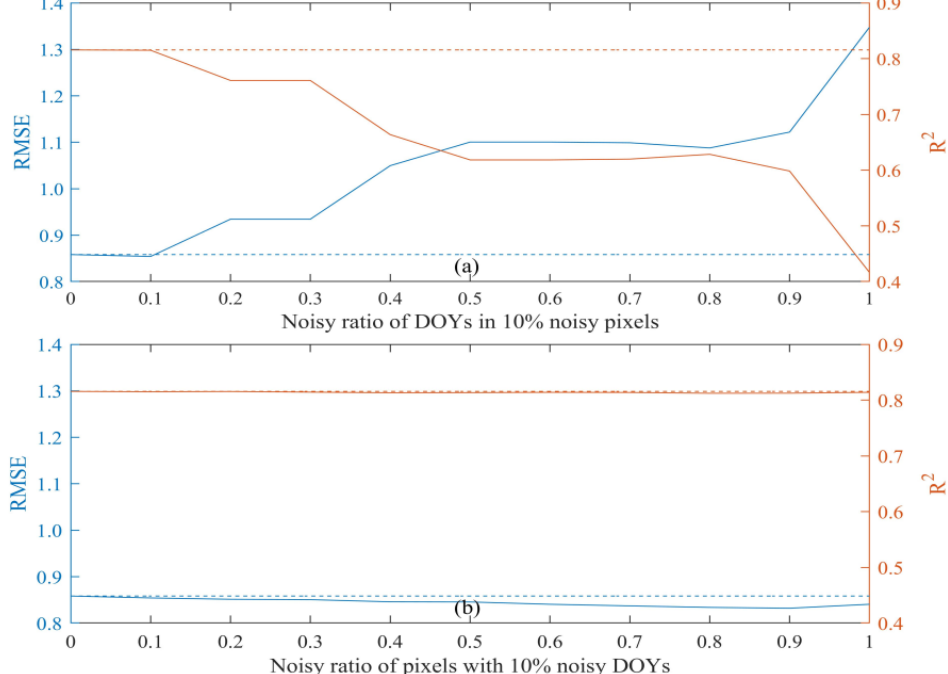
Figure 11. Variations in the retrieval accuracies of LSTM fusion based on ( a ) the 10% contaminated reflectance pixels with different ratios of noisy DOYs and ( b ) the 10% noisy DOYs with various ratios of reflectance pixels in 2016. The blue and red dotted lines separately represent the RMSE and R 2 of the LSTM fusion -retrieved accuracy without contaminated data in